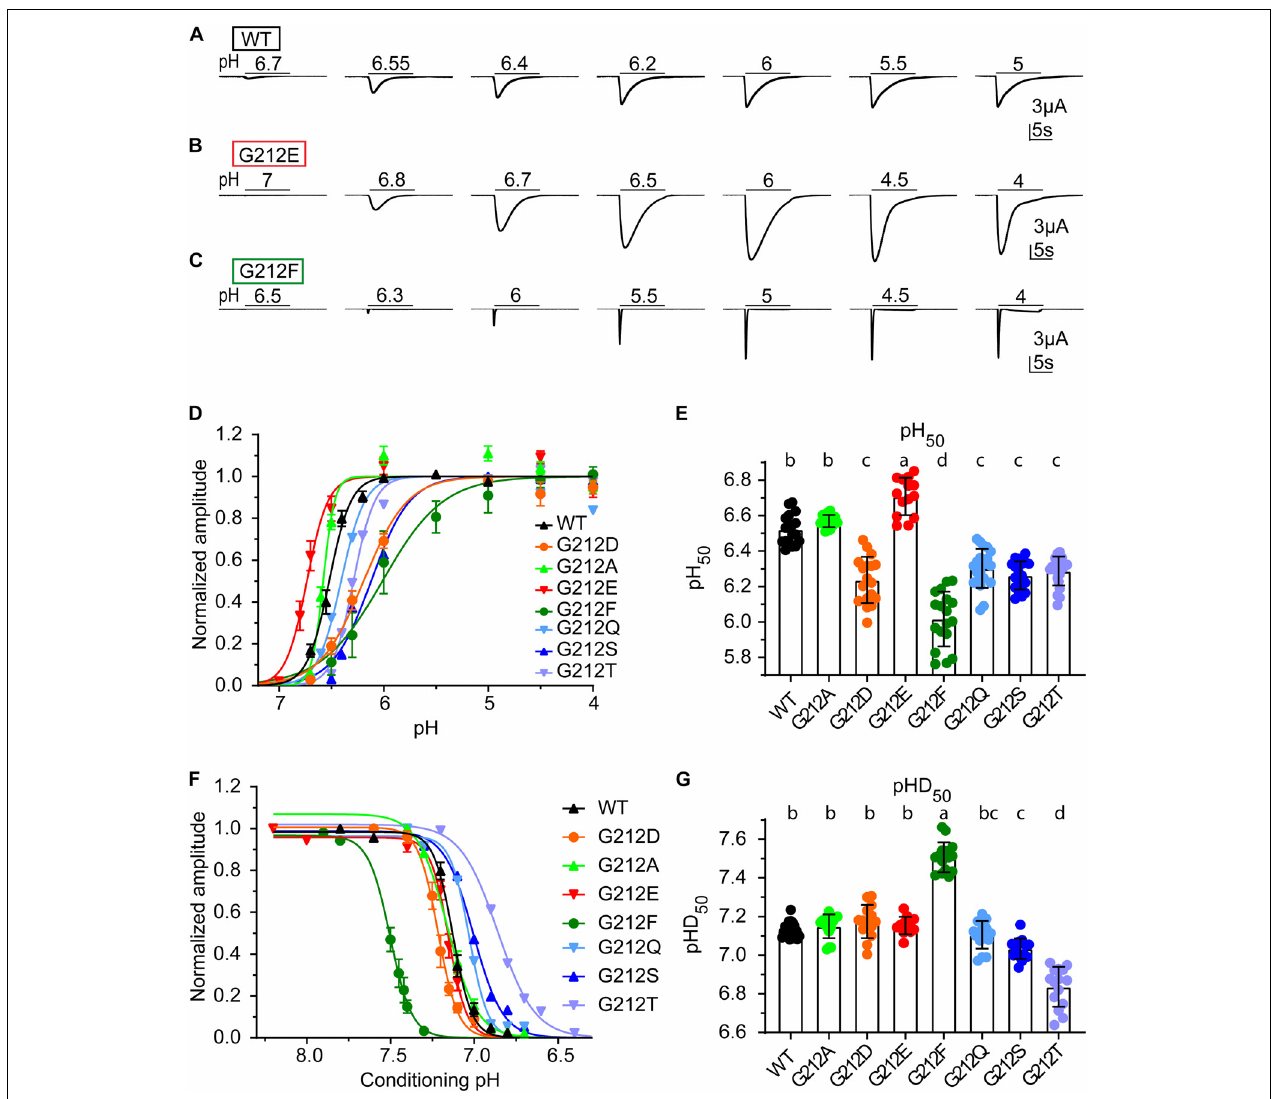
FIGURE 2 | Functional differences of Gly212 mutants. (A–C) Representative current traces of activation curves with ASIC1a WT (A) , G212D (B) and G212F (C) . (D) pH dependence of activation of WT and Gly212 mutants ( n = 13–22). A series of pH stimulations was applied for 10 s each, and between, oocytes were perfused with pH 7.4 (pH7.8 for G212F) conditioning solution during 50 s. (E) Plot of the pH 50 (pH of half-maximal amplitude) values of WT and Gly212 mutants. Bars that do not share the same letters are significantly different ( n = 14–22, p < 0.05). (F) Steady-state desensitization (SSD) curve, plotting the normalized current amplitude as a function of the conditioning pH, of WT and Gly212 mutants ( n = 8–17). The curve was obtained by applying the conditioning pH for 55 s followed by application of pH5 for 5 s. (G) Plot of pHD 50 values. Bars that do not share the same letters are significantly different ( n = 12–21, p <